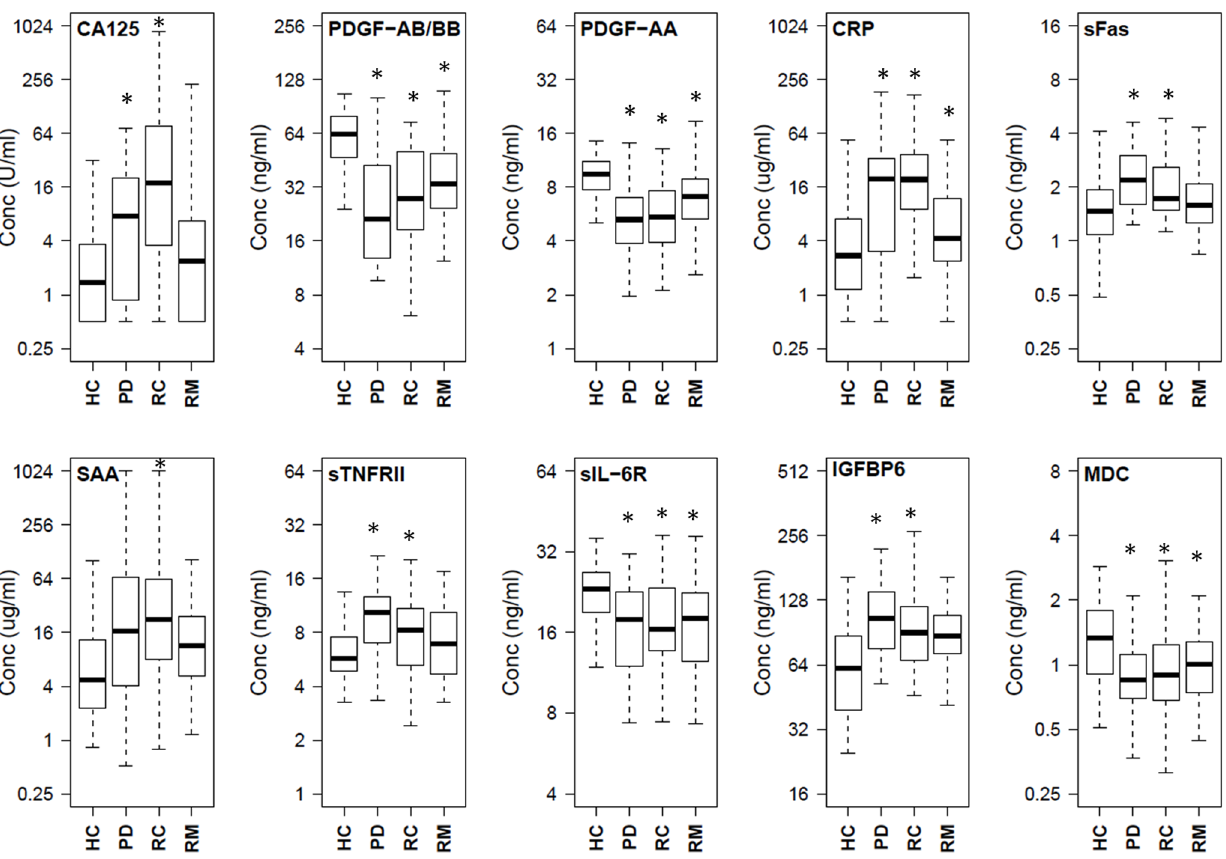
Figure 1. Boxplots representing the serum protein levels in patient subgroups and healthy controls. PD: Post Diagnosis, RC: Recurrence, RM: Remission, HC: Healthy Controls. (*) significant difference as compared to healthy controls.